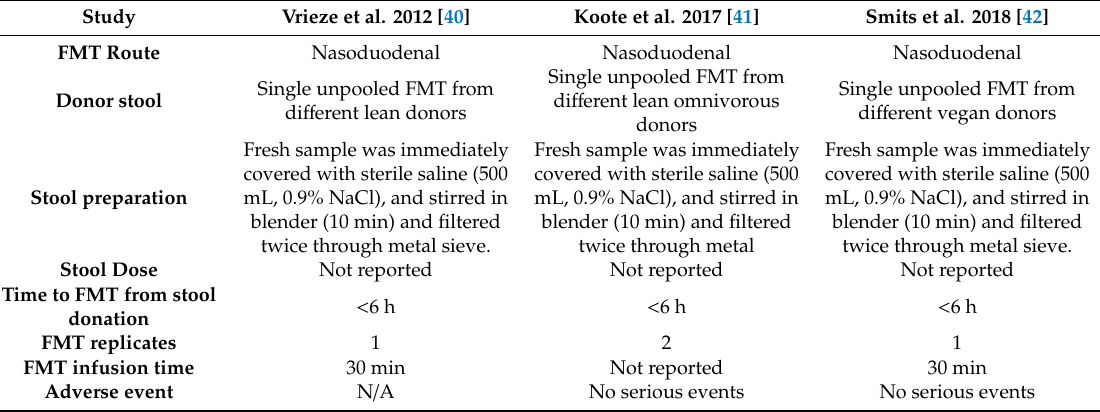
Table 3. Summary of donor stool processing and delivery methods in randomized controlled trials of FMT for obese and metabolic